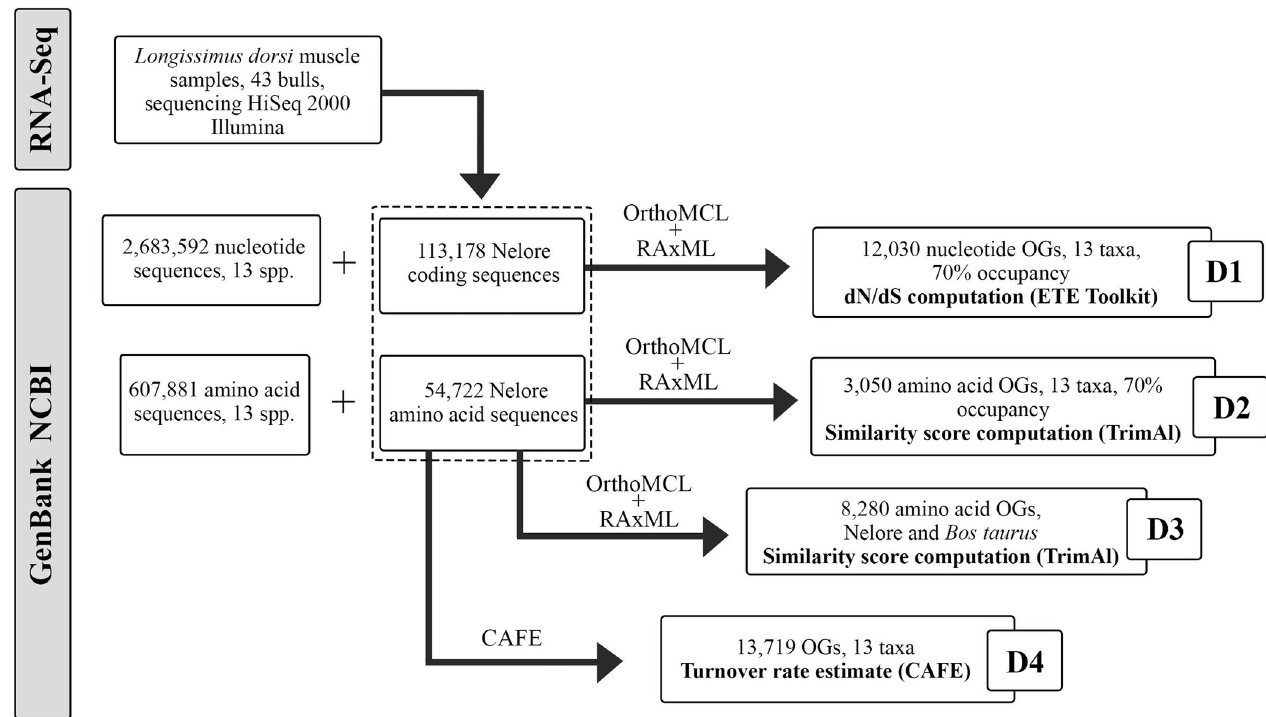
Fig 1. Schematic description of each dataset, orthologous groups (OGs) assignment and analyses performed.